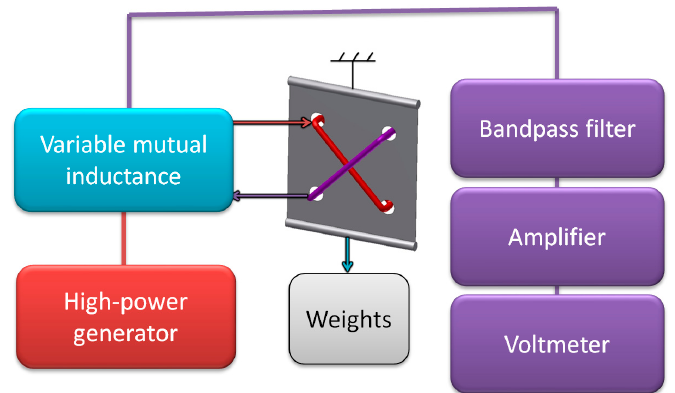
Figure 9. Schematic diagram of the improved measurement test stand.